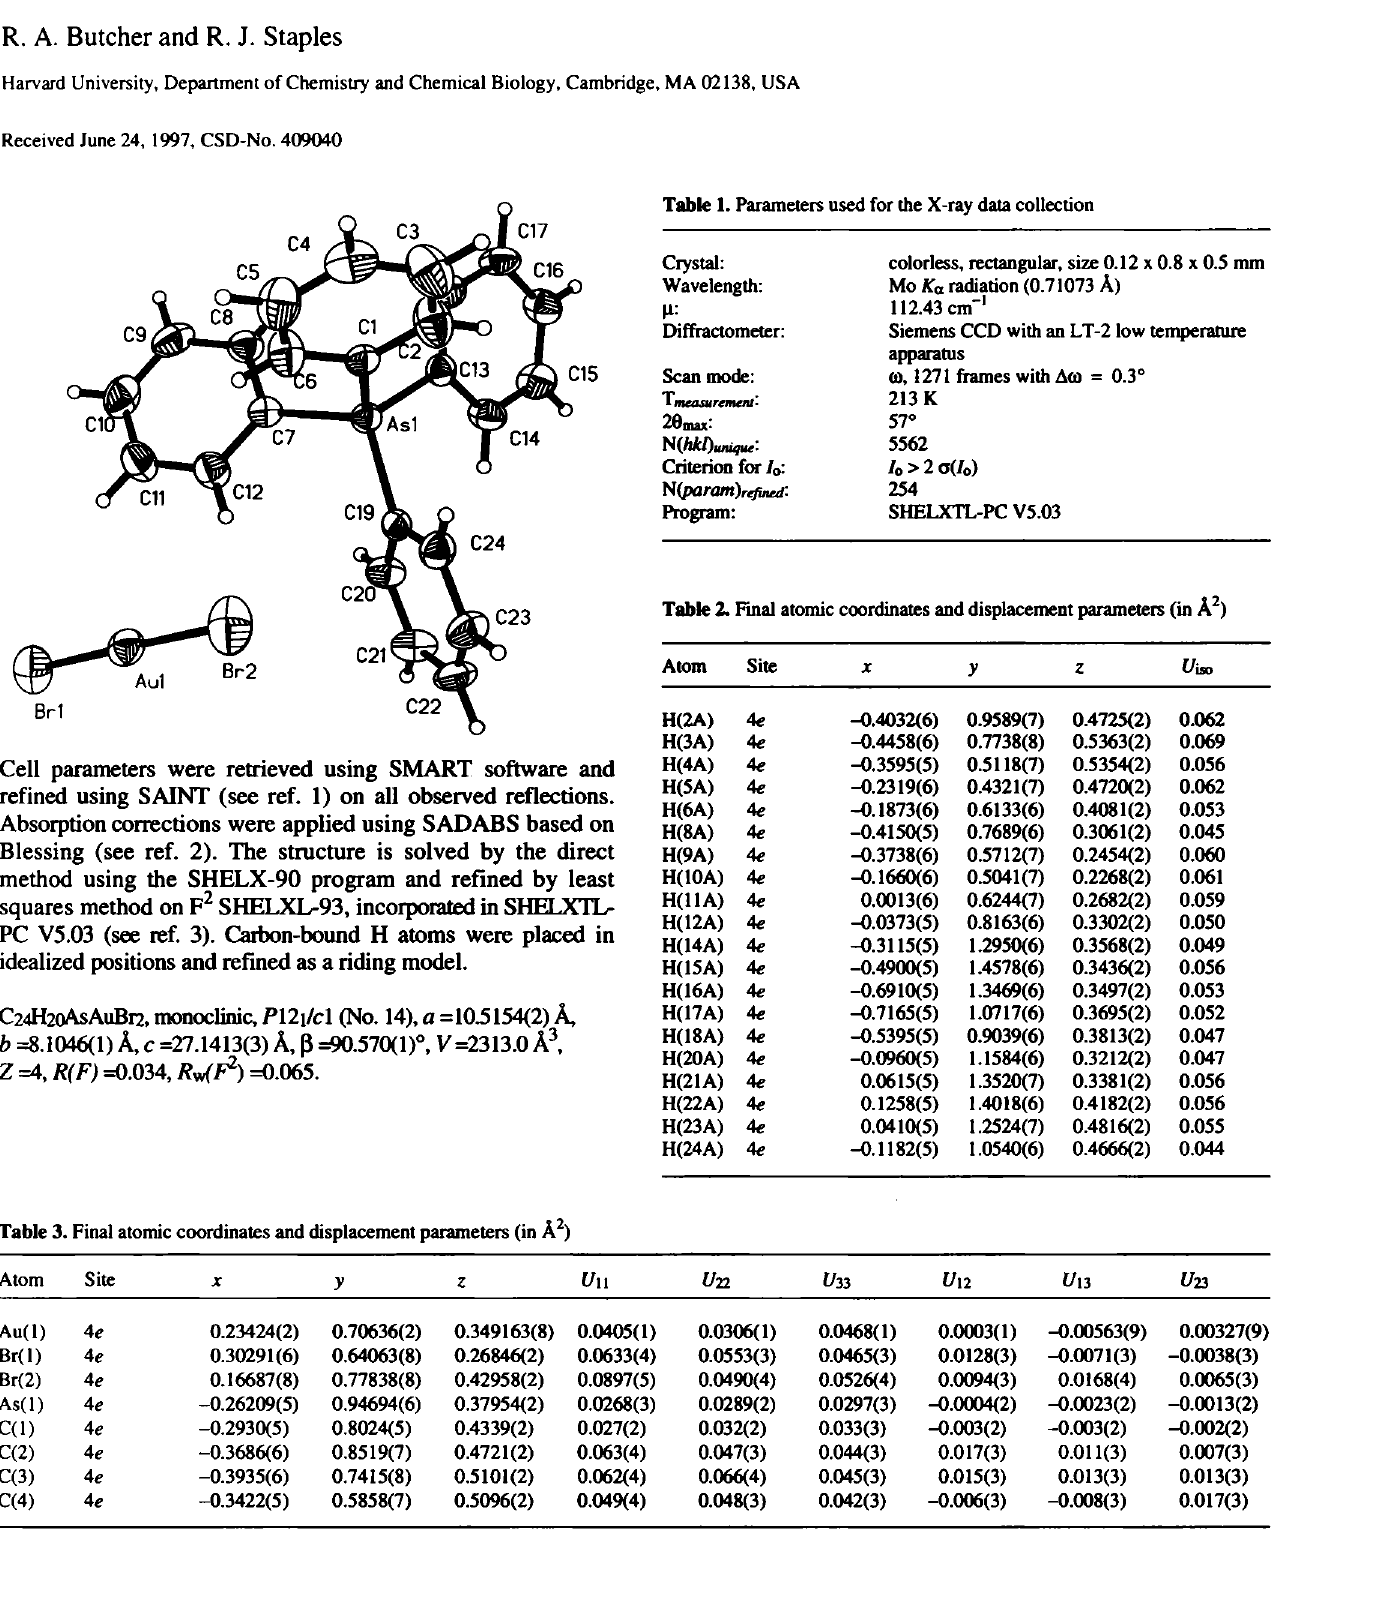
Table 1. Parameters used for the X-ray data collection